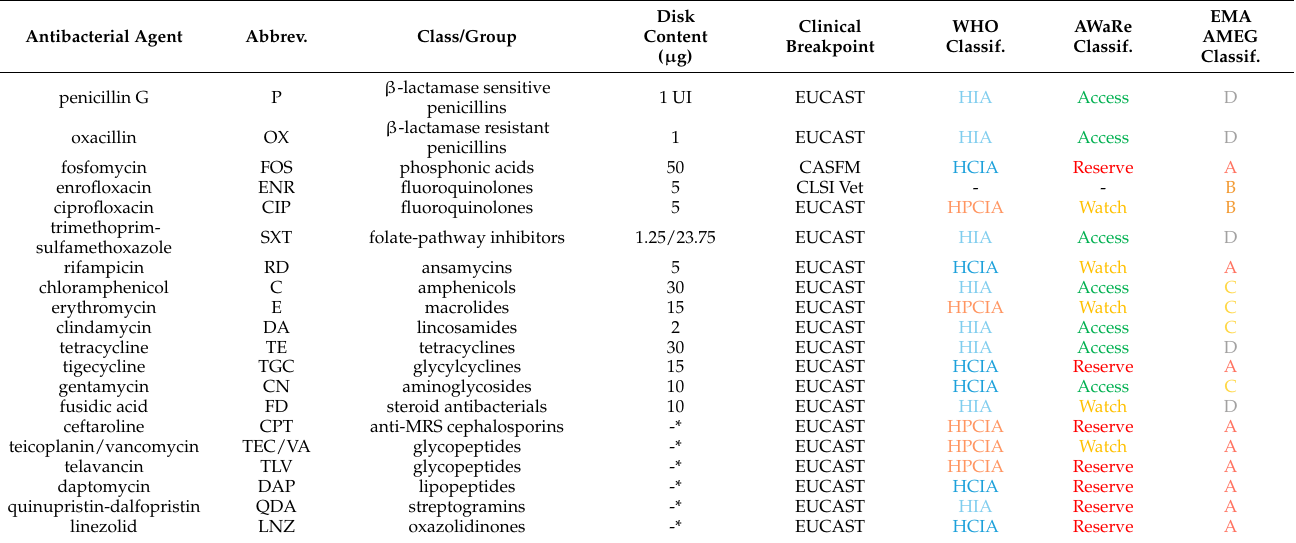
Table 5. List of the 20 tested antibacterials and their classes/groups. The table reports the disk content (for ADD), the clinical breakpoint standards used for interpretation, and WHO, AWaRe and EMA AMEG classifications for each